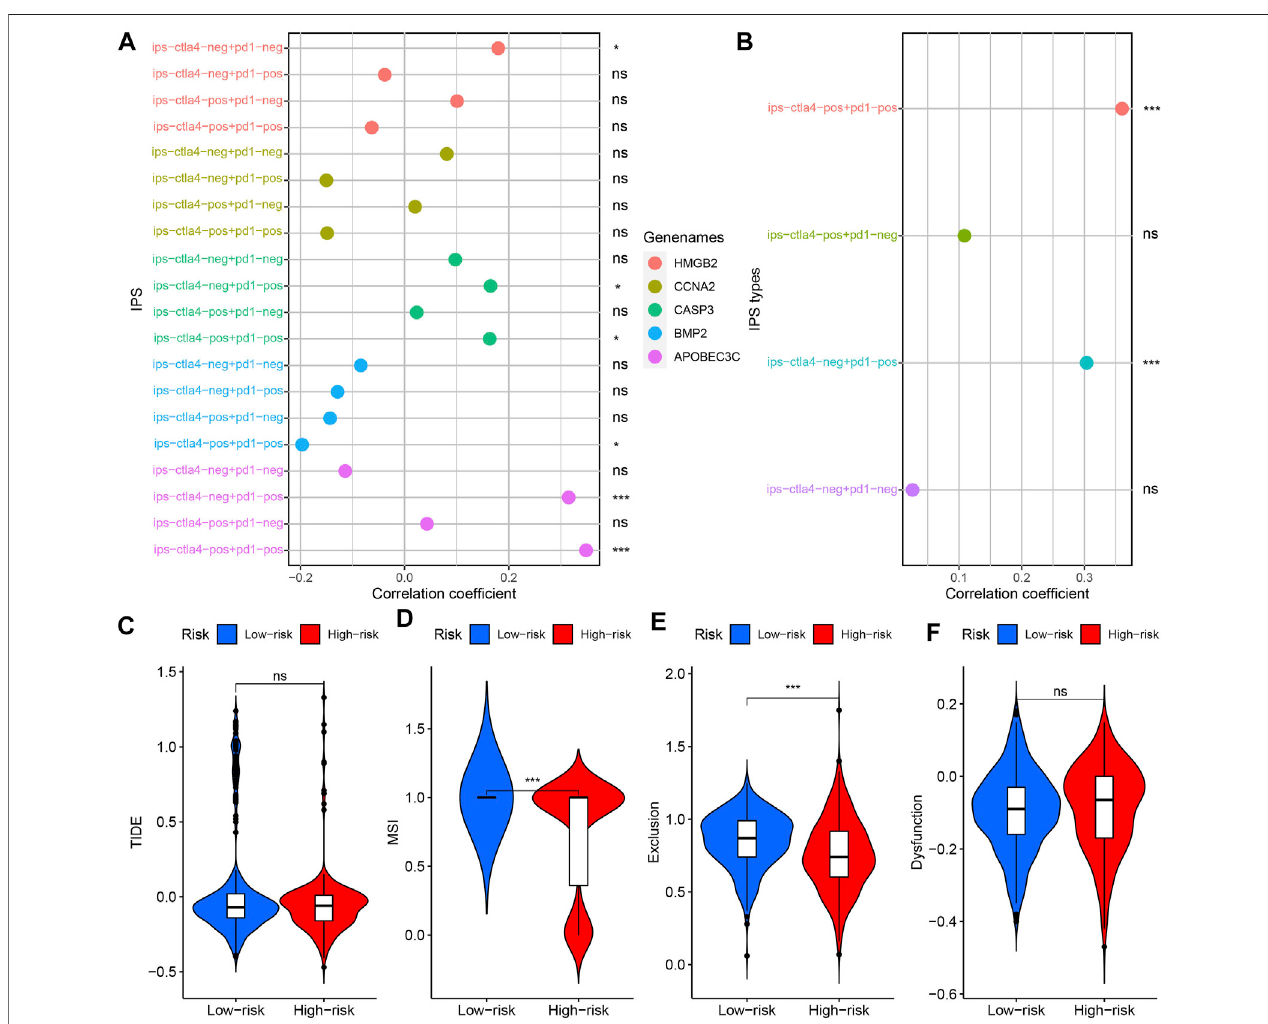
FIGURE 11 | Model ’ s guiding value in ICIs therapy. (A) Correlation analysis results between 4 kinds of IPSs and 5 PR-DE-IRGs. (B) Correlation analysis results between 4 kinds of IPSs and risk score. (C – F) Difference in TIDE, MSI, T cell dysfunction and exclusion scores between high-risk and low-risk groups. ns: meaningless; * p < 0.05; ** p < 0.01; *** p <